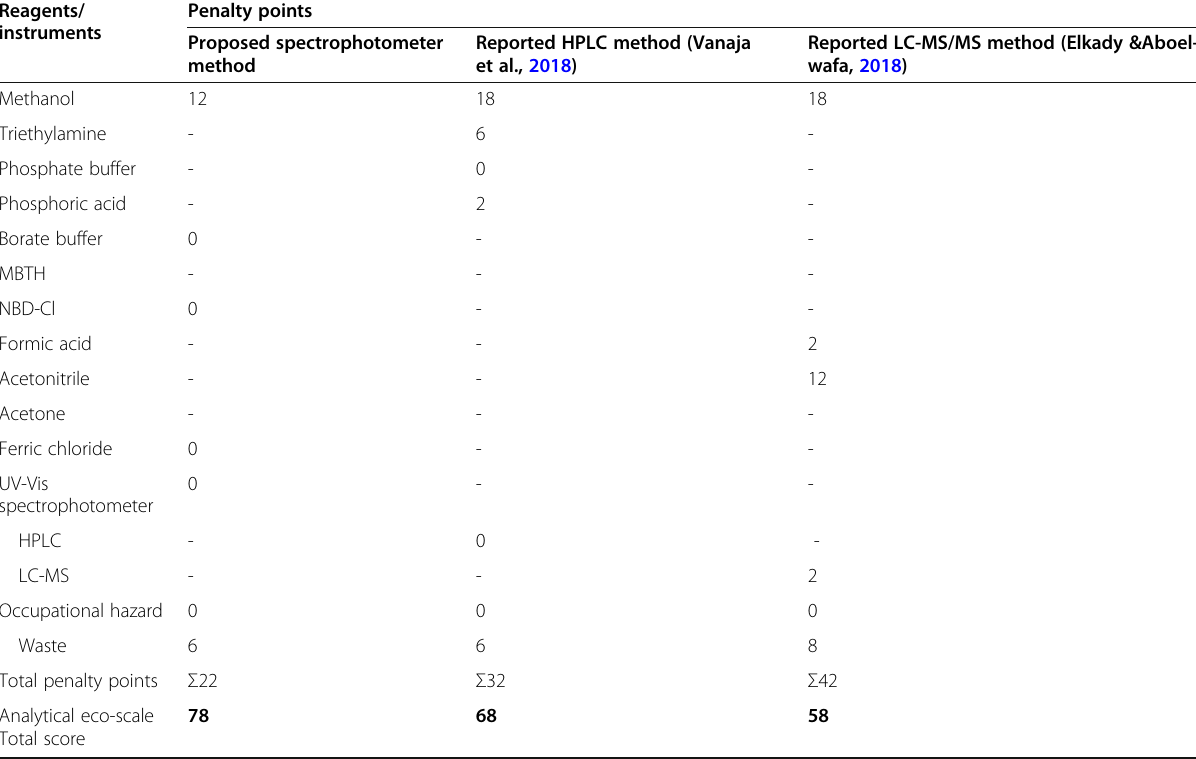
Table 7 The penalty points for the determination of SF and VP for the reported methods and the proposed spectrophotometric method Reagents/